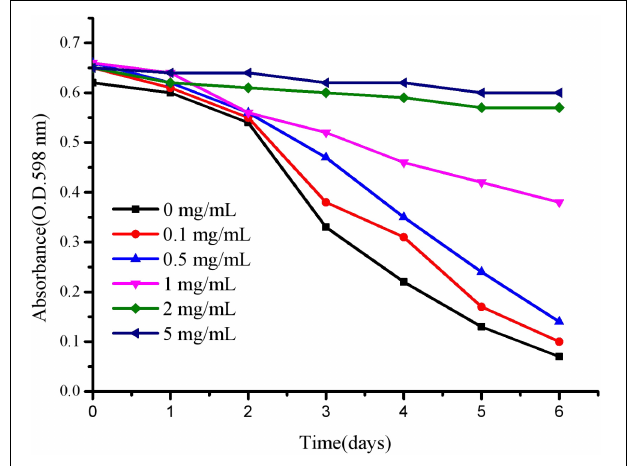
FIGURE 7 | The OD of E. coli is reported daily for each concentration of